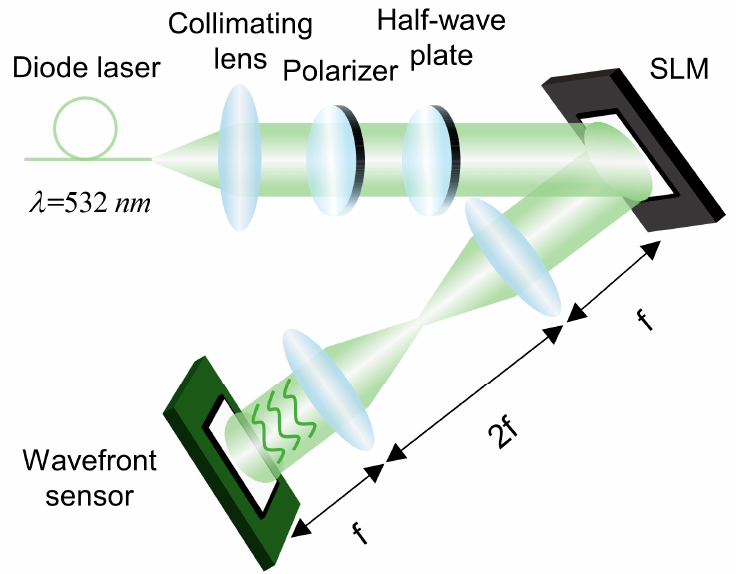
Figure 4. Schematic diagram of the experimental setup for measuring complex wavefronts. The SLM is used to generate a certain wavefront. Figure 5a presents the grayscale map loaded onto the SLM. For each SLM pattern in our experiment, we first generated a random curve using three random sine functions summed together. Then, we used the repmat function in MATLAB to expand the random curve to create a grayscale image with a resolution of 1920 × 1080. These grayscale maps are continuous and can be used to model complex wavefronts. Our wavefront sensor provided direct access to gradient information. The Zernike polynomials could be used to reconstruct the wavefront. As can be seen from Figure 5b, the wavefront was faithfully reconstructed. We also show the gradient information in Figure 5c. These arrows indicated the rapid changes in the wavefront. Our sensor could measure large phase gradients, making it easy to resolve these